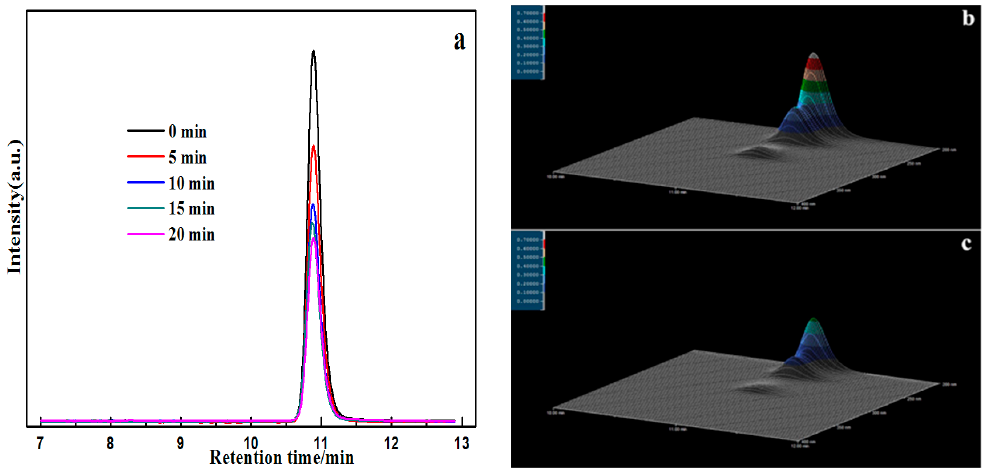
Figure 14. ( a ) HPLC chromatograms of BPA solutions with Ag@AgCl (10 wt %)/Bi 2 O 2 CO 3 photocatalytic catalyst; ( b ) Three-dimensional HPLC chromatographic spectra of BPA degradation (0 min); ( c ) Three-dimensional HPLC chromatographic spectra of BPA degradation (30 min).